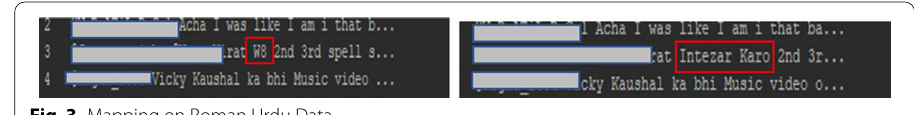
Fig. 3 Mapping on Roman Urdu